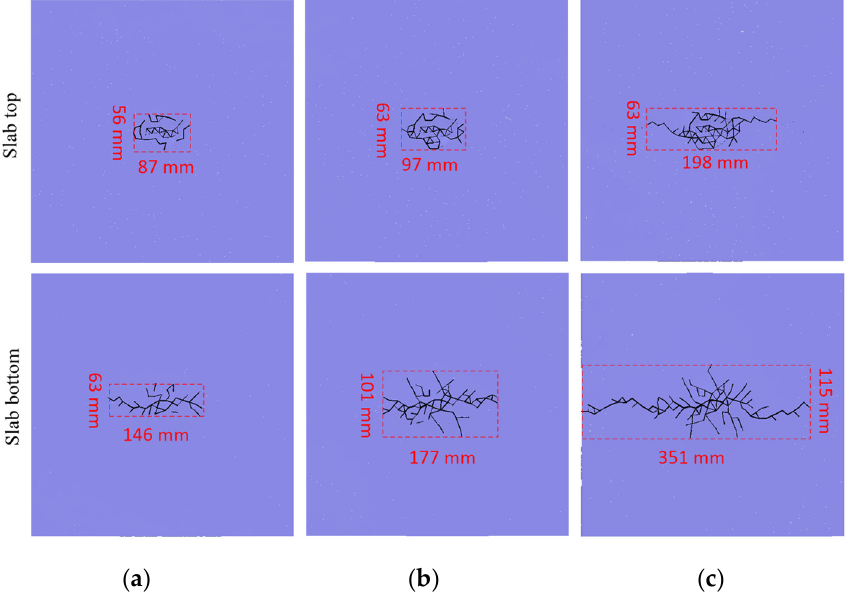
Figure 8. Crack distribution on the slab’s top and bottom under different impact velocities: ( a ) 3 m/s impact; ( b ) 4 m/s impact; ( c ) 5 m/s impact.